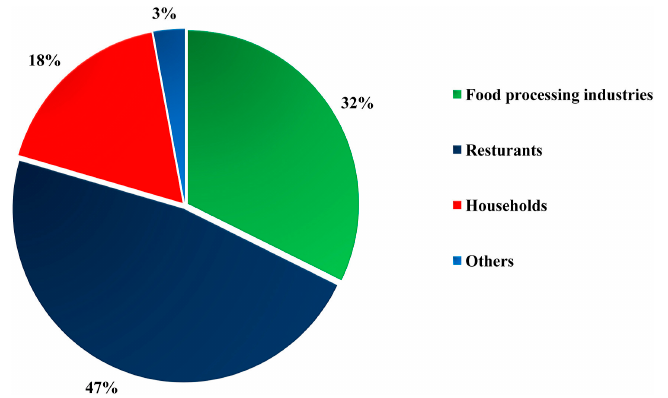
Figure 9. The Sources of waste cooked oil [138].